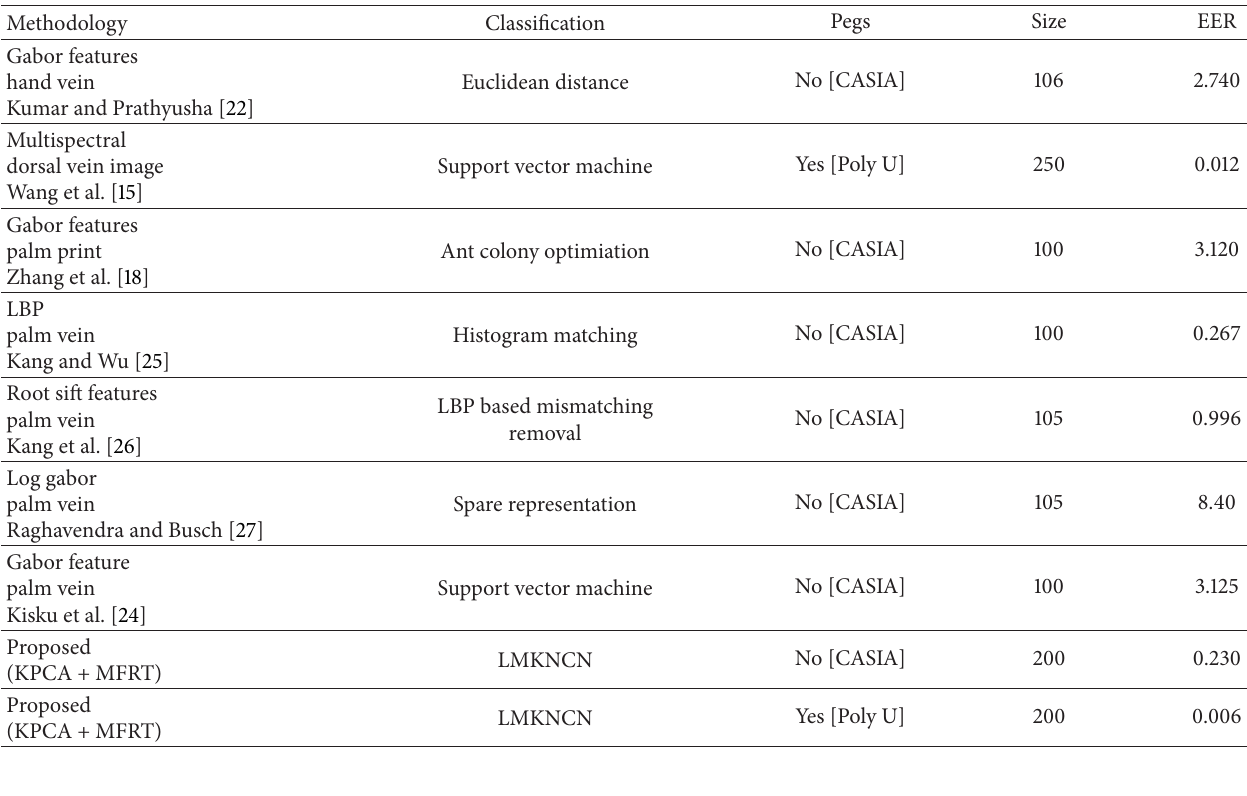
Table 9: Comparison of multispectral palm print approaches.